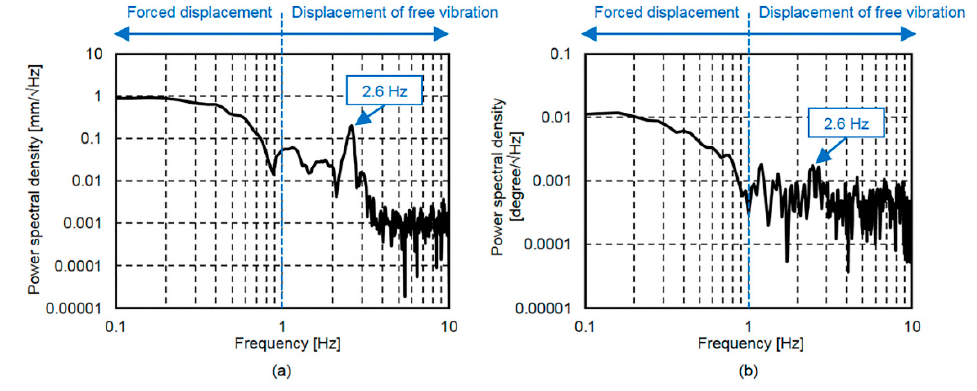
Figure 9. Detailed bridge response spectrum at G4: ( a ) displacement response spectrum; and ( b ) rotation angle response spectrum.